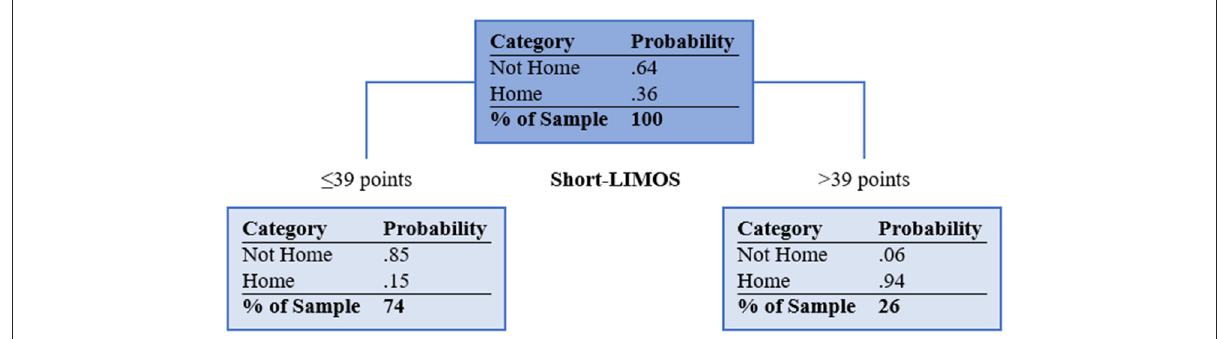
FIGURE2 Pruned classification and regression tree. Light blue filled boxes represent the terminal nodes. Short-LIMOS, Short Version of the Lucerne ICF-Based Multidisciplinary Observation Scale. In case of missing Short-LIMOS data, age was used as a surrogate marker ( < 55.5 for discharge home vs. ≥ 55.5 years for no discharge home).